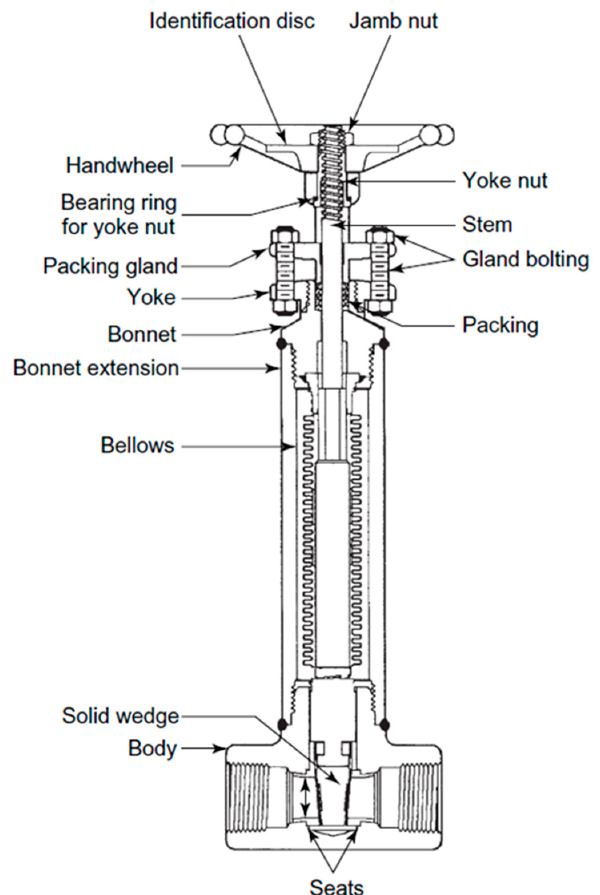
Figure 1. Bellow valve working principle [4] (Reproduced with permission from Robert Flitney, Seals and Sealing Handbook; published by ELSEVIER, 2014).